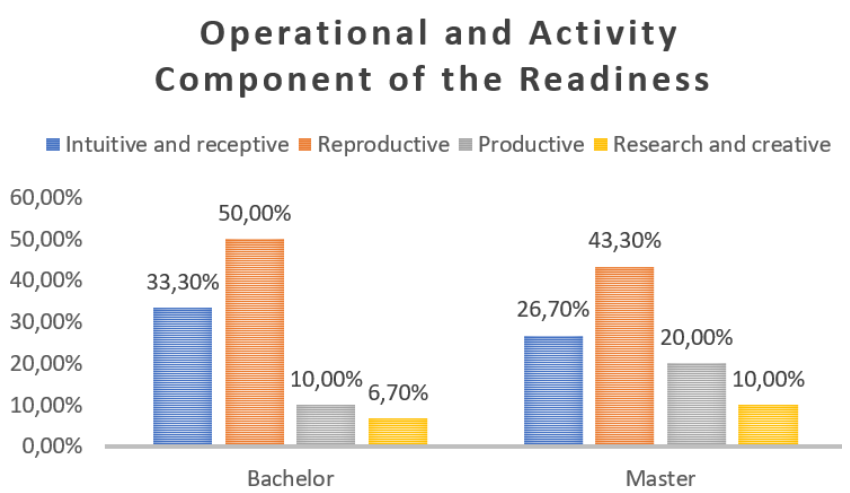
Figure 2: Diagram of the development of the operational and activity component of the future primary education specialists’ readiness to use digital educational resources.